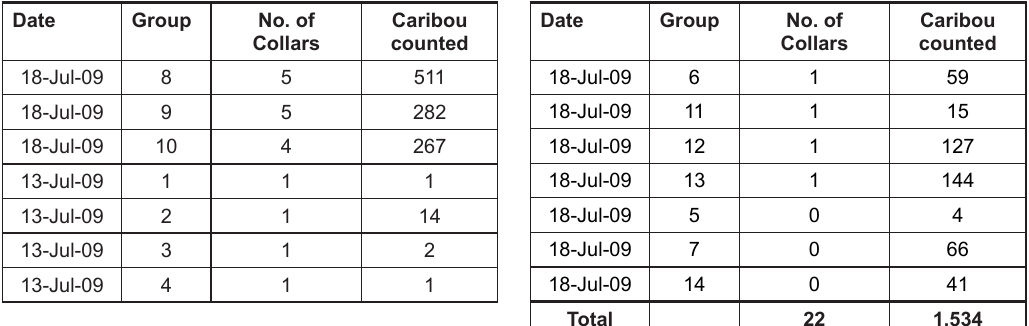
Table 28. Post calving field data for Cape Bathurst 2009 survey.